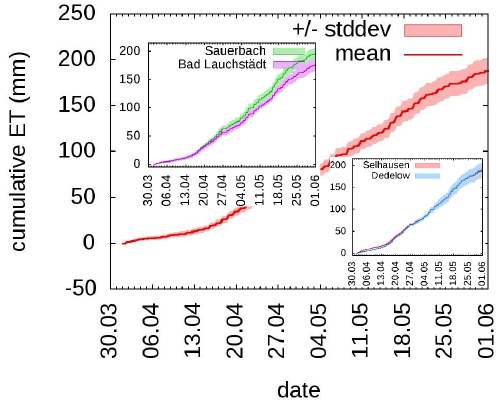
Figure 12. Cumulative evapotranspiration (mean ± standard devia- tion) for the 12 crop lysimeters of the Bad Lauchstädt test site. The small picture shows the results separated in soil type